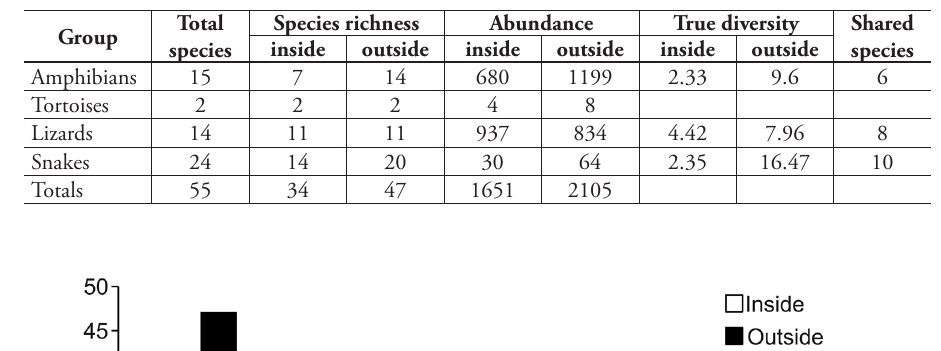
Table 2. Summary of values of diversity and abundance by taxonomic group registered inside and outside REBSSJ, Nayarit, Mexico.